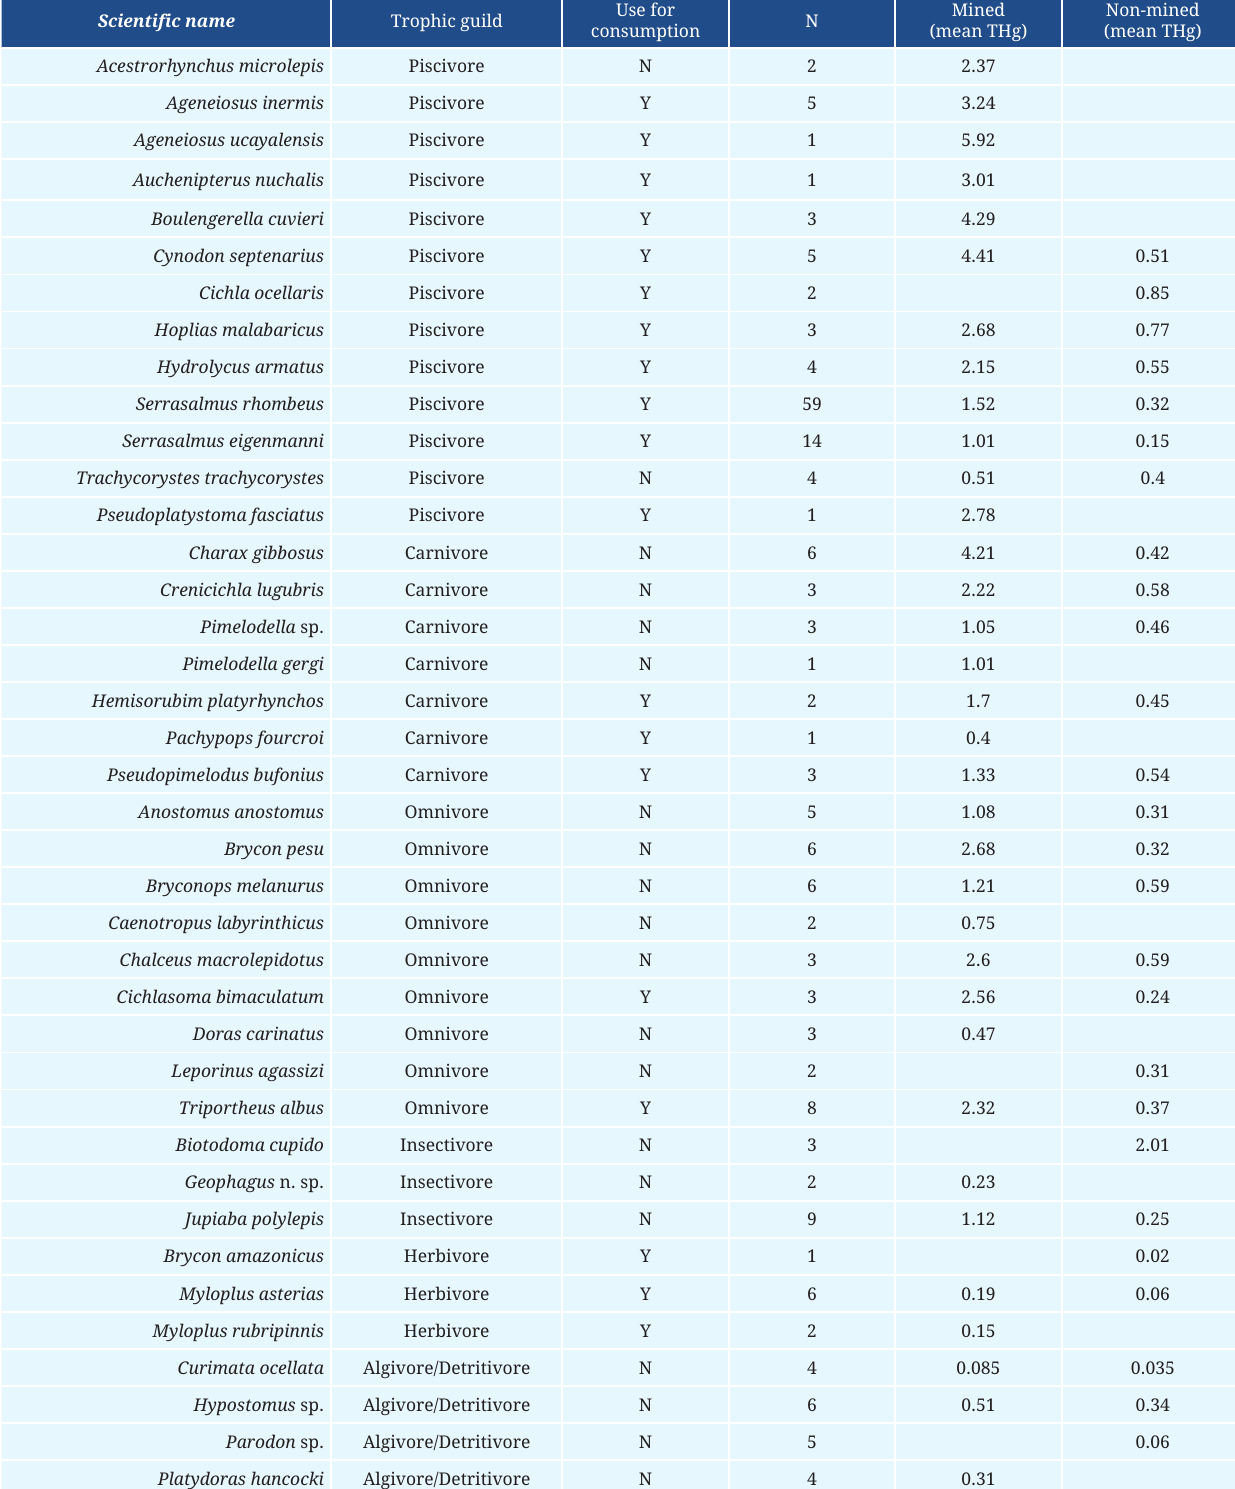
TABLE 1 | Fish species and their mean mercury concentrations (μg Hg/g, dry weight) from mined or non-mined sites. Species were classified to trophic guilds based on published literature. N indicates total number of samples